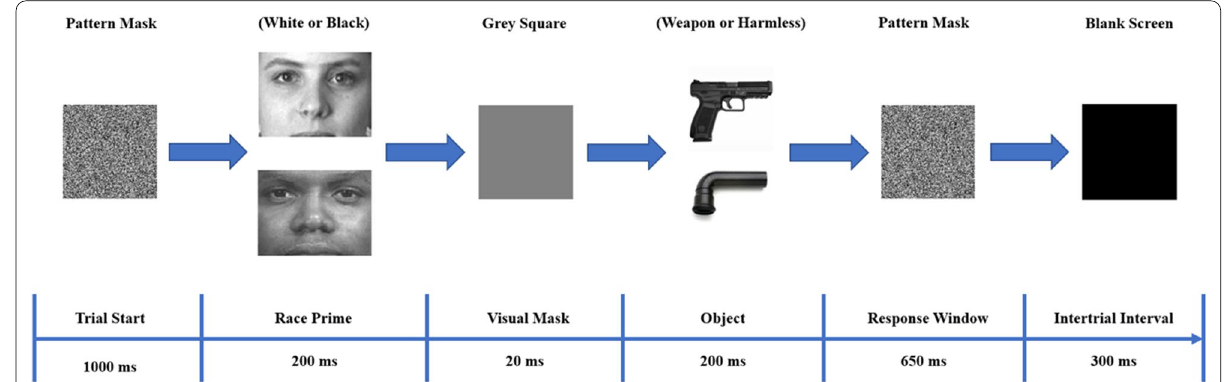
Fig. 1 Example trial from the weapon identification task used in the current study, adapted from Payne